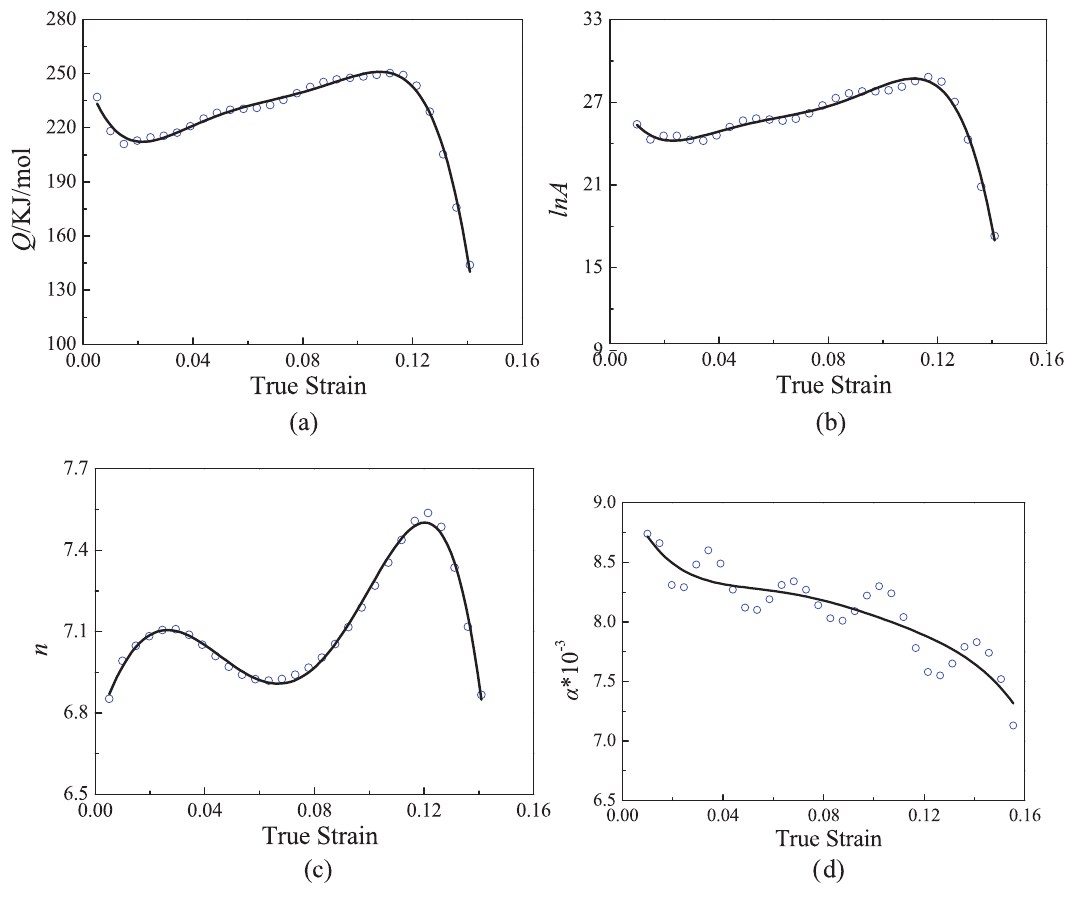
Fig. 6: Relationships between: (a) Q ; (b) ln A ; (c) n ; (d) a and true strain e by polynomial fit